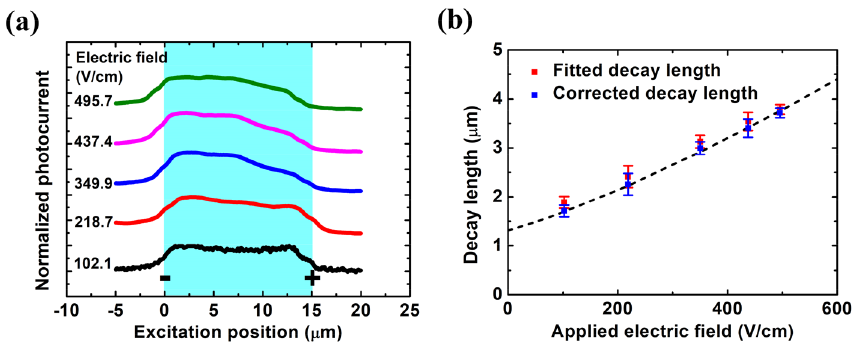
Figure 7. SPCM measurement in an InGaAs air-bridge two-terminal thin-film device. ( a ) Scanning photocurrent profiles with varied applied electric field under pumping density of 29 W·cm −2 . ( b ) L fit and corrected decay lengths fitted in ( a ) as a function of the applied electric field. The dashed line shows the fitting curve using Eq. (2). L ch of the measured thin-film device is 15 μm shown with blue background and the excitation spot size is around 800 nm. The photocurrent profiles in ( a ) is offset vertically for